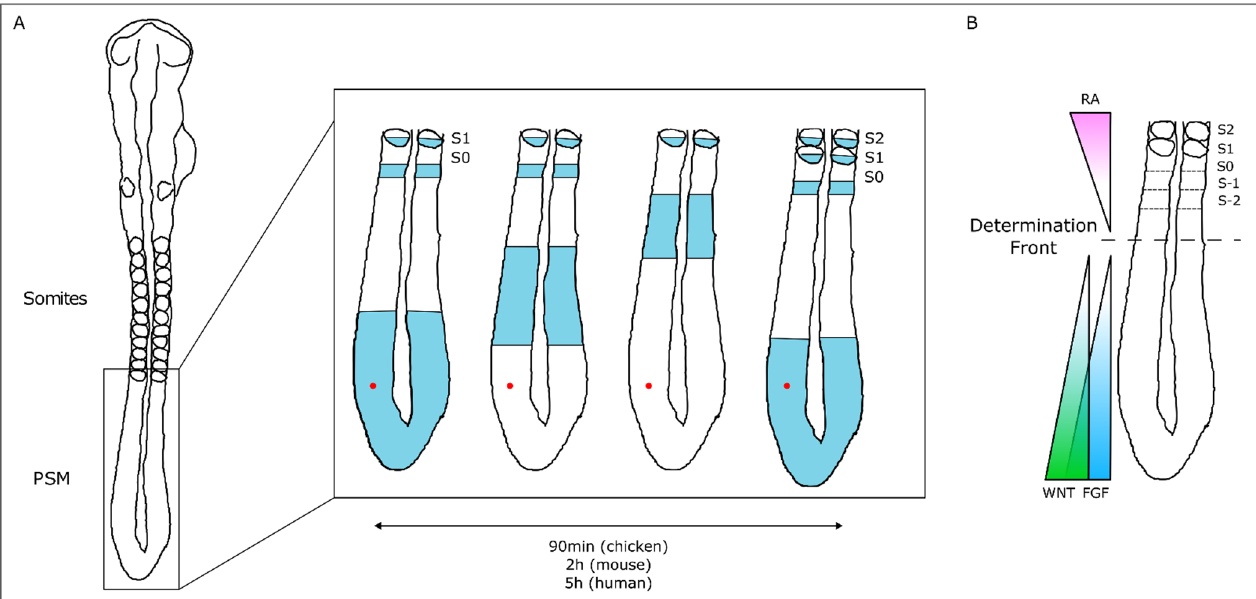
Figure 2. The Molecular Clock and Signaling Gradients in temporal/spatial control of vertebrate somitogenesis. ( A ) Representation of one oscillation of hairy1 gene expression (blue) in the presomitic mesoderm (PSM) of a 48h chicken embryo. A cell in the PSM (red dot) undergoes a complete cycle of gene expression activation-repression-activation as a new somite is formed in the anterior-most PSM. ( B ) Opposing gradients of retinoic acid (RA) and WNT/FGF signaling converge at the determination front; rostrally, the PSM tissue is already committed to form somites.